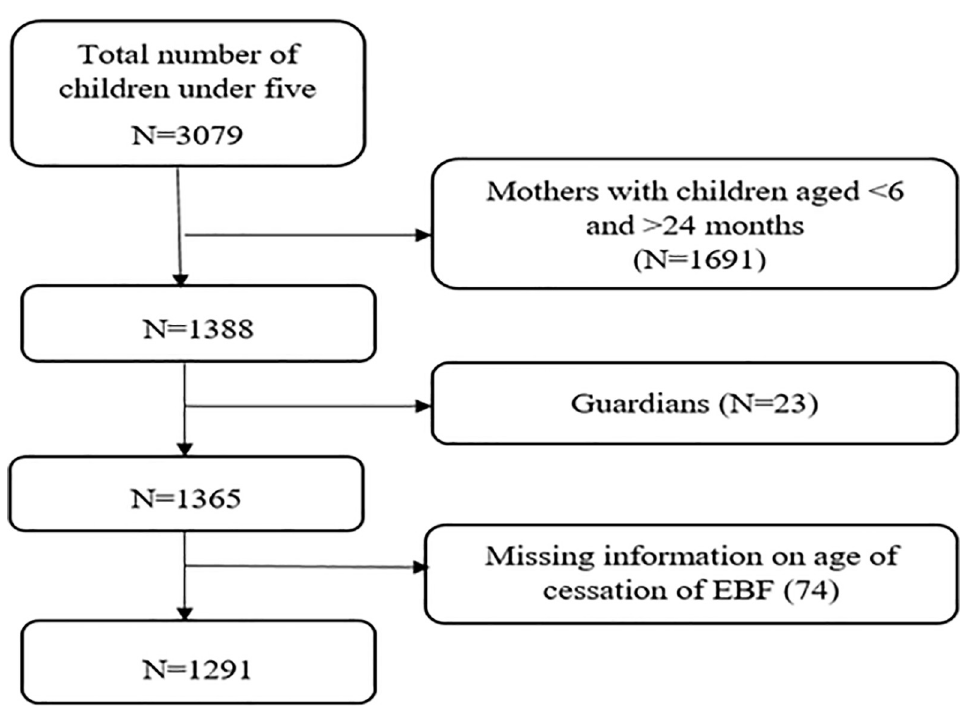
Fig 1. Schematic diagram showing the sample size used in the